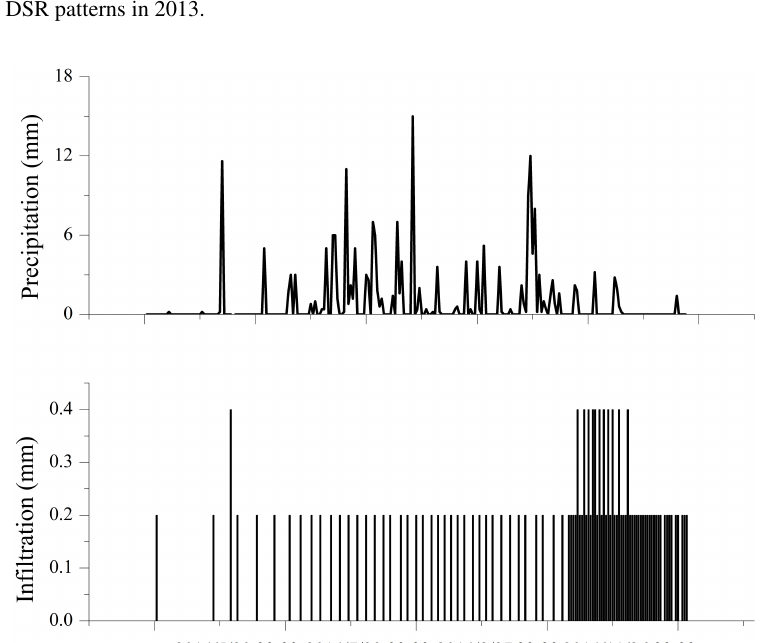
Figure 4. Precipitation and DSR patterns in